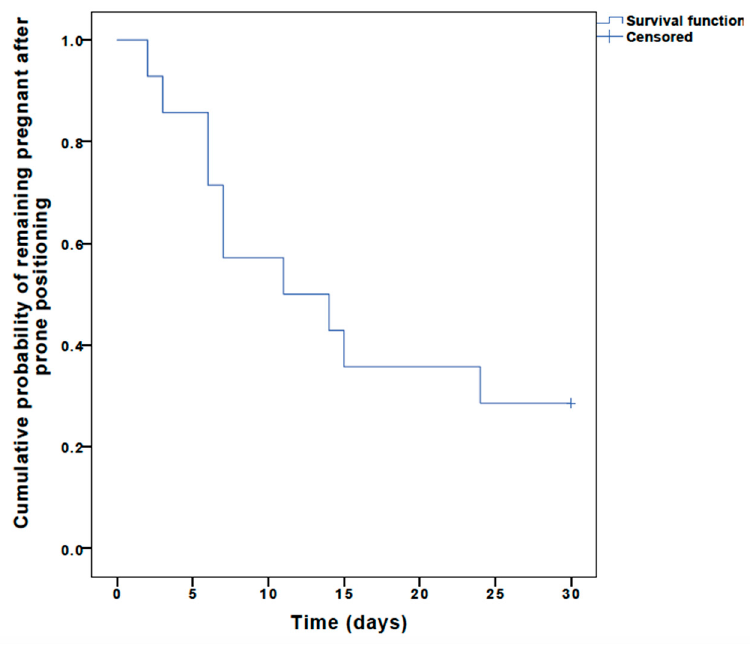
Figure 1. Kaplan–Meier survival curve representing time that women remained pregnant after prone positioning. Table 3. Respiratory and hemodynamic responses to prone positioning ( n = 16). One-way ANOVA was performed to compare effects of PP on blood gas parameters. Prone positioning was associated with the sustained improvement of PaO 2 /FiO 2 ratio (T 0 : 102.7 ± 26.9 mmHg, T 1 : 189.2 ± 71.5 mmHg and T 2 : 187.1 ± 71.6 mmHg, p < 0.001) and Table 3). PP had a medium effect size for the sustained improvement of the PaO 2 /FiO 2 ratio (Cohen’s f = 0.56) and PaCO 2 (Cohen’s f = 0.46). Post hoc analyses confirmed that PP was related to an increased PaO 2 /FiO 2 ratio at T 1 ( p = 0.001) and T 2 ( p = 0.001), and to a